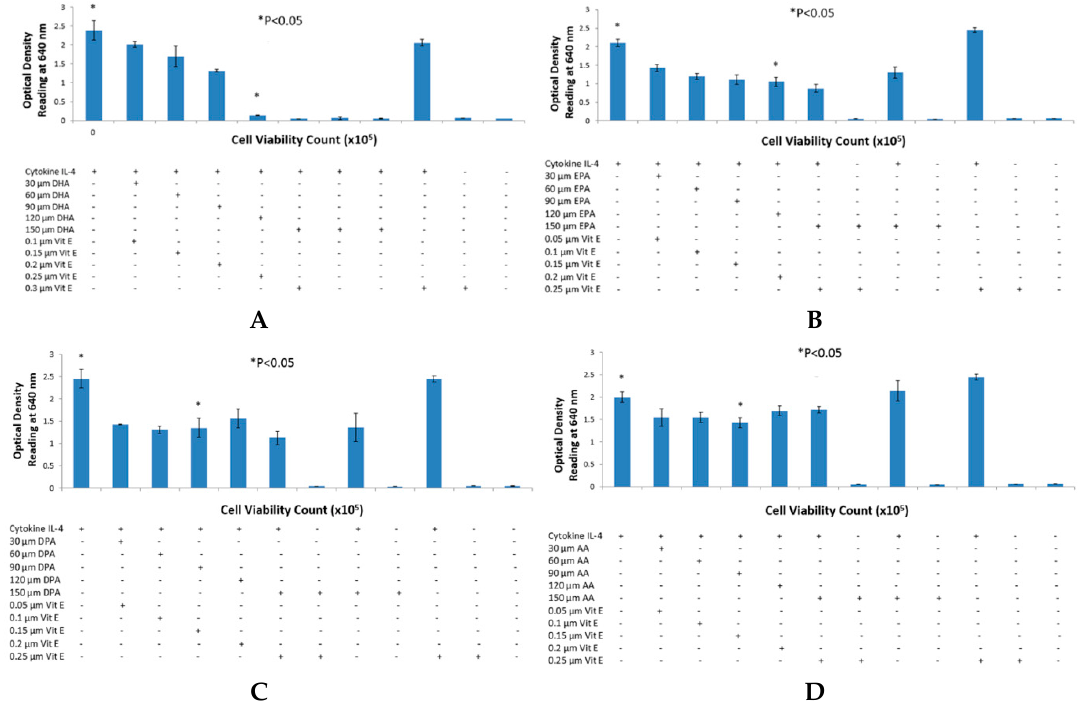
Figure 1. IL-4 detection assay with n-3 and n-6 fatty acids ( μ M) with HEK-Blue Cells using Quanti-Blue. ( A , B ) shows the detection assay performed with docosahexanoic acid (DHA) and eicosapentanoic acid (EPA), respectively, with a dose-dependent inhibition; However in ( C , D ), a dose-dependent inhibition does not occur with docosapentanoic acid (DPA) and arachidonic acid (AA) but rather a dose-response inhibition occurs. n-3 fatty acids showed no abnormal effects on secreted embryonic alkaline phosphatase (SEAP) secretion without vitamin E. However, AA without vitamin E caused higher than normal SEAP secretion. * p < 0.05 denotes significance of optical density (OD) readings compared to positivecontrol.